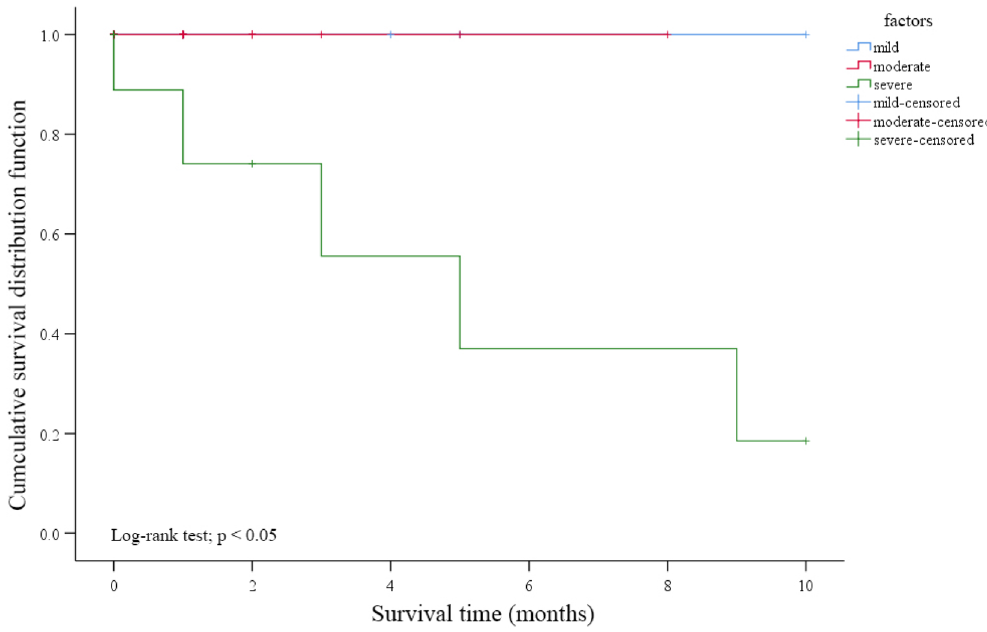
Figure 7. Kaplan–Meier survival curves for each grade of dysplasia after PDT treatment. Severe epithelial dysplasia patients were a significantly higher risk of developing new severe epithelial dysplasia and even